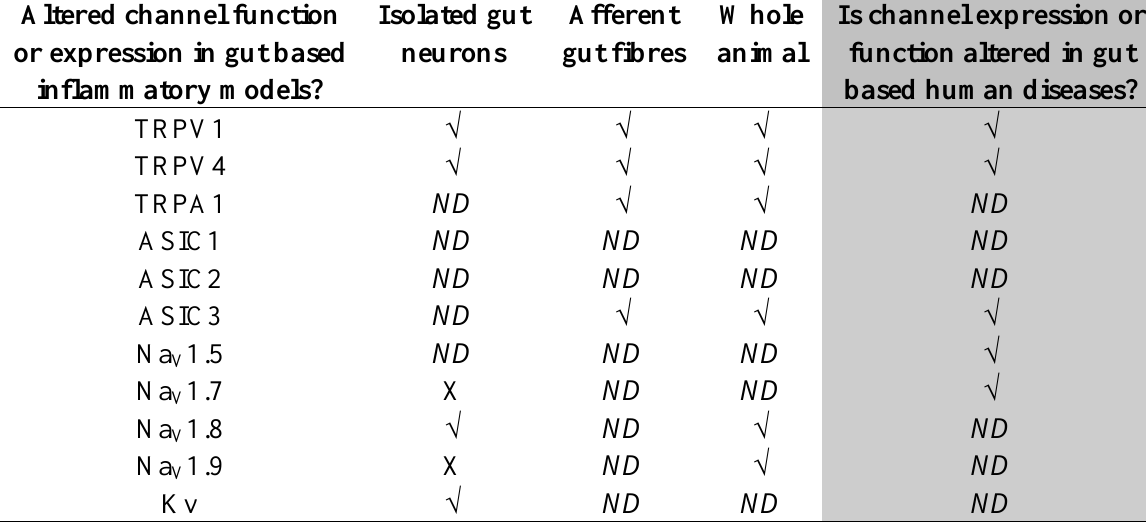
Table 2. Summarizes the ion channels implicated in signaling gut based “inflammatory” or “chronic” pain and details where (gut innervating neurons, gut innervating afferents or whole animal gut based recordings) this function was demonstrated. This table also documents which channels have altered expression in gut based human pain